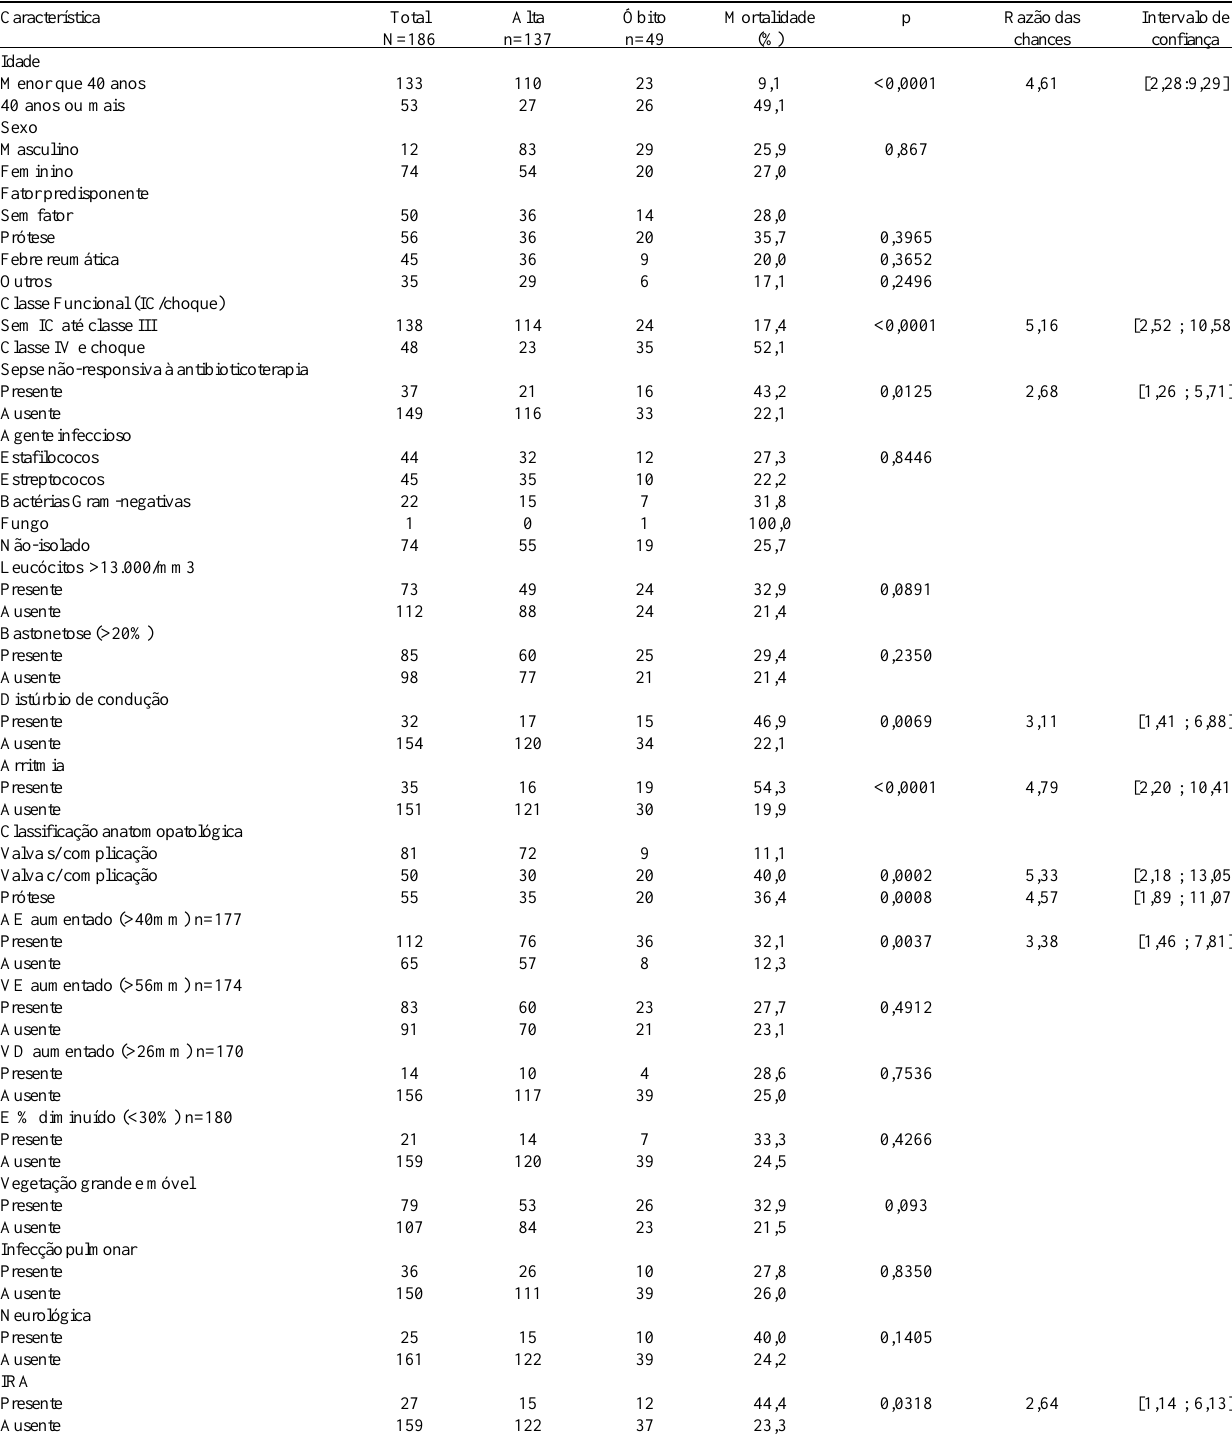
Tabela 1. Mortalidade em análise univariada de variáveis qualitativas. Característica Idade Menor que 40